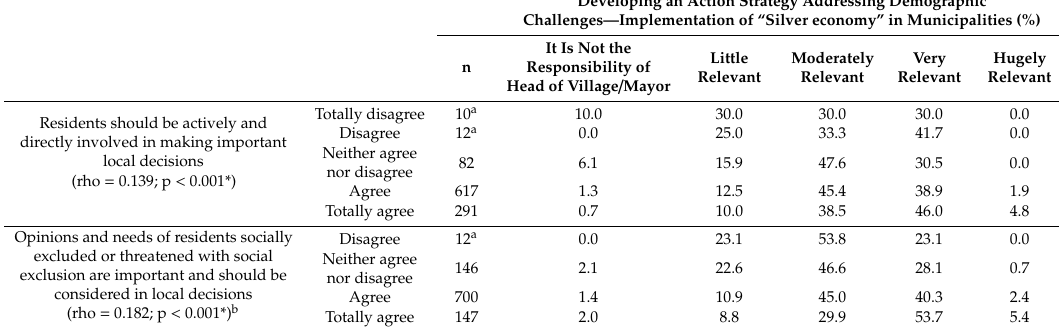
Table 6. Perception of residents’ involvement in local decision making and the relevance of developing andimplementingactionstrategyvis- à -visdemographicchallengesandsilvereconomyinmunicipalities (in